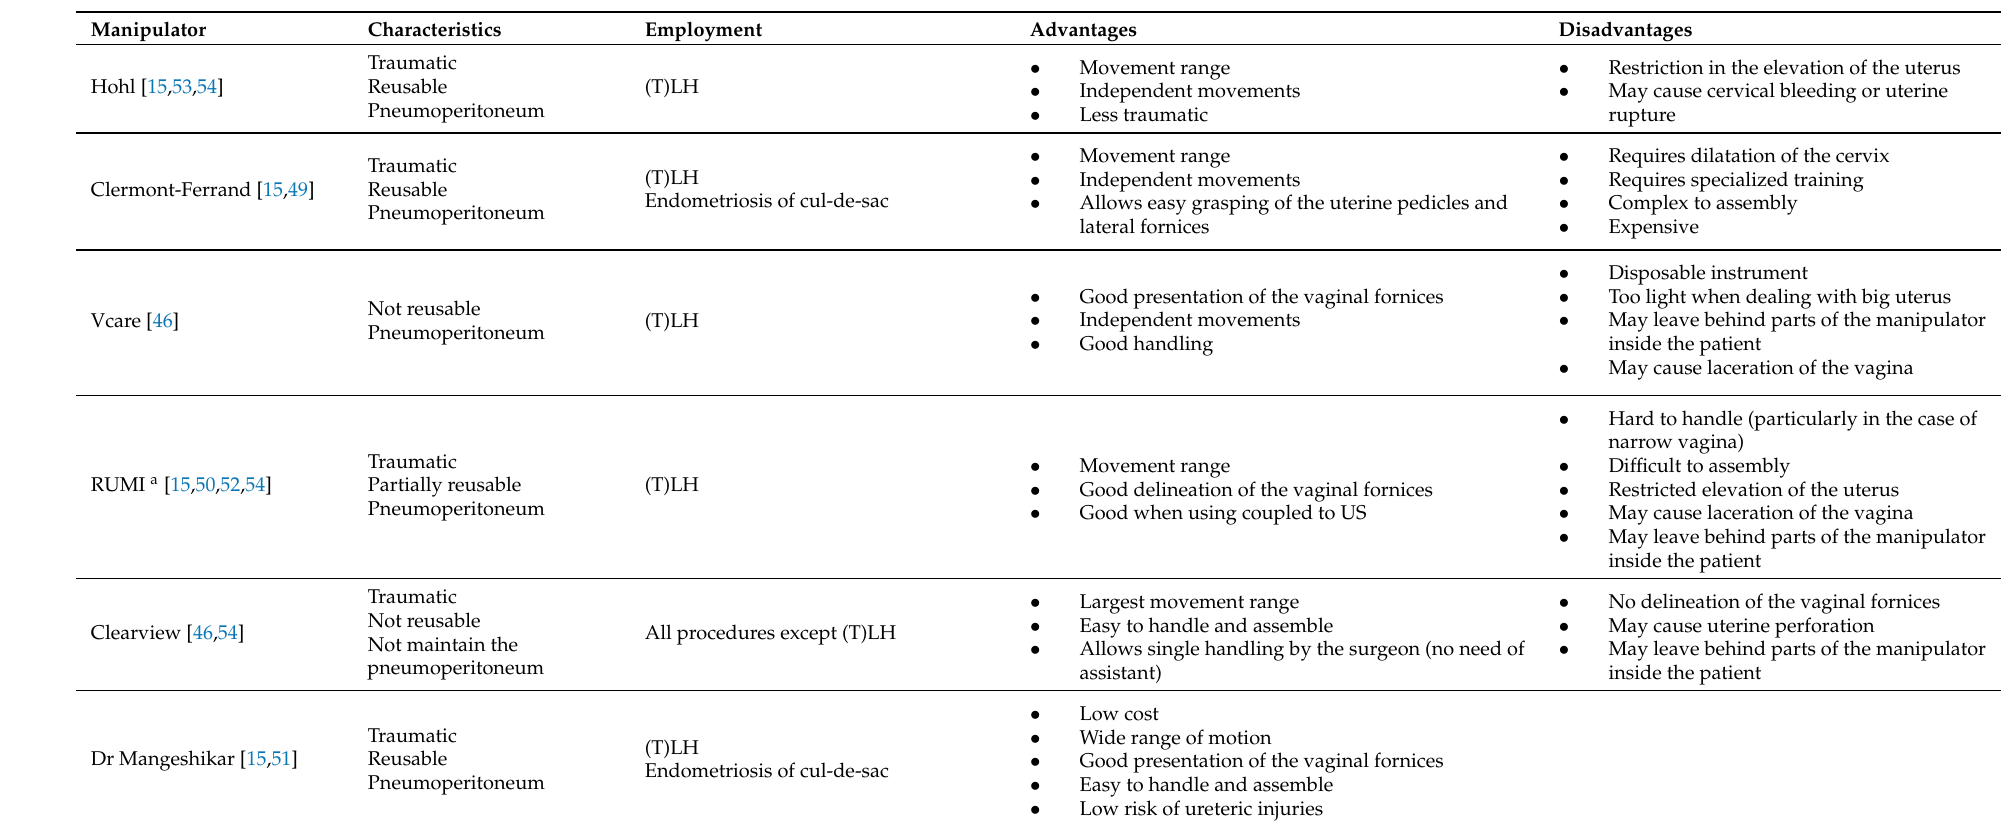
Table 1. Summary of the main features, indications, advantages, and disadvantages of the manipulators.